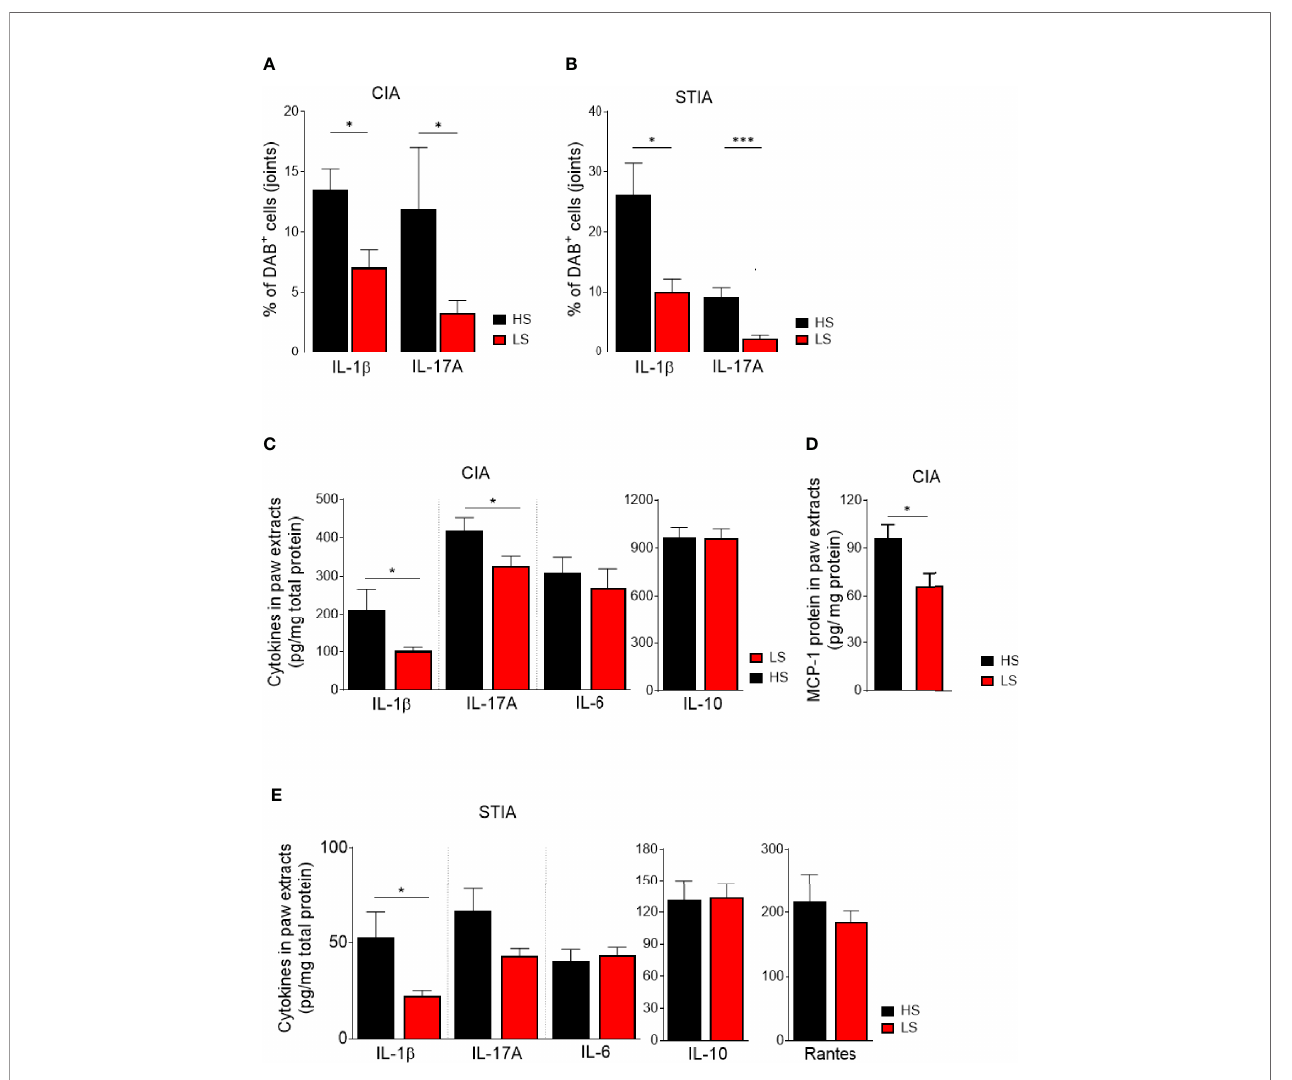
FIGURE 7 | Analysis of cytokine expression in joints. Paraf fi n-embedded sections of CIA (A) and STIA (B) hind paws were immunohistochemically stained for IL-1beta, IL-17A, and isotype control. Positive cells were stained in brown (3,3 ′ -diaminobenzidine 4-HCl, DAB). Hematoxylin (blue) was used for counterstaining. Quanti fi cation of IL-1beta and IL-17A stained joint sections. Sections of four randomly chosen mice of each group from one experiment were used and three fi elds per section were analyzed. * p < 0.05, *** p < 0.001. p -values were calculated by Student ’ s t -test. (C) Front paw extracts were prepared at day 47 post CII immunization and analyzed for IL-1beta, IL-17A, IL-6, and IL-10. (D) MCP-1 content (day 20) by ELISA (day 47: LS, n = 16; HS, n = 14; day 20: LS, n = 9; HS, n = 10). * p < 0.05. p-values were calculated by Student ’ s t-test. (E) Front paw extracts from STIA mice were isolated at 8 days post serum transfer and analyzed for the respective cytokines by ELISA (HS, n = 16; LS, n = 16). * p < 0.05. p -values were calculated by Student ’ s t -test. All data were expressed as ±